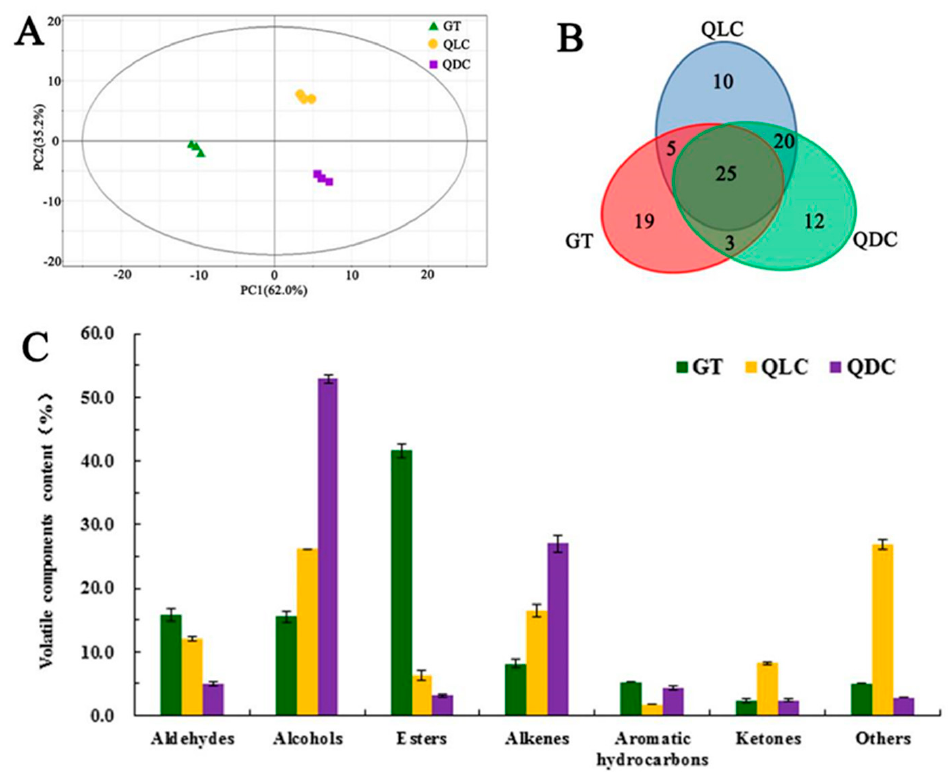
Figure 4. Analysis of volatile components of the three tea samples. ( A ). PCA score plot derived from the concentrations of volatile components of the three tea samples. ( B ). Venn diagram of the volatile components from the three tea samples. ( C ). The volatile component types of the three tea samples.